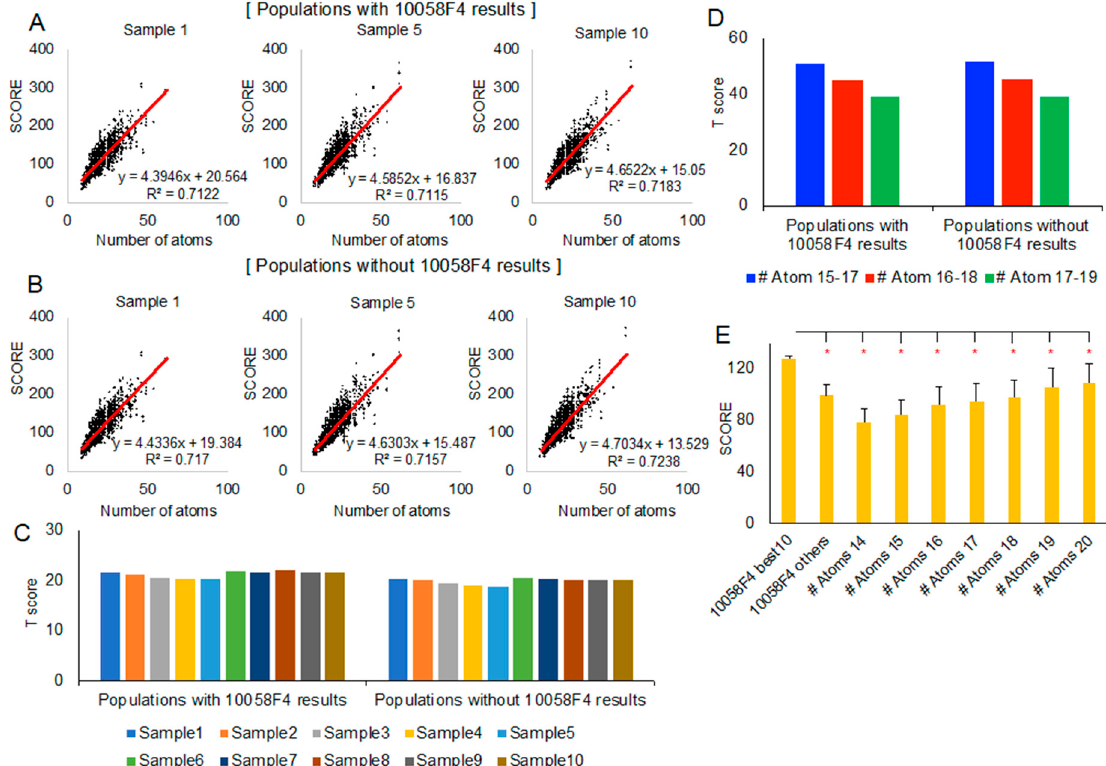
Figure 4. Statistical analysis of the new docking evaluation score focusing on 10058F4–MYC 390–409 region peptides: ( A , B ) Linear regression between docking-involved atom number ( x -axis) and the new docking evaluation score ( y -axis) with 10058F4 docking results in the population ( A ) and without 10058F4 docking results in the population ( B ). ( C ) The 10 best 10058F4 docking result T scores in 10 random samples (considering each sample as a population) with / without 10058F4 docking results. ( D ) The 10 best 10058F4 docking result T scores in three di ff erent docking-involved atom number groups (15–17, 16–18, and 17–19) with / without 10058 docking results from all 10 random samples. ( E ) T -test between the 10 best 10058F4 docking results and each of the docking-involved atom number groups (14–20) from all 10 random samples. * p -value <